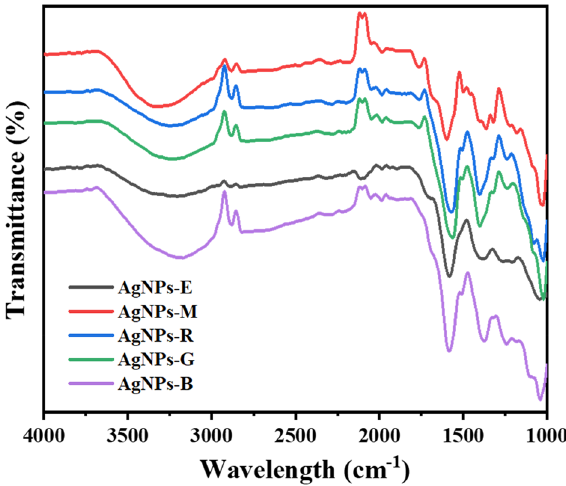
Figure 2. FTIR spectra of AgNPs biosynthesized using the leaf extracts of Eucalyptus , Melia , Ruta , Geranium , and Basil (with a shift of the transmittance axis for a 10% space between spectra for clarity of results).